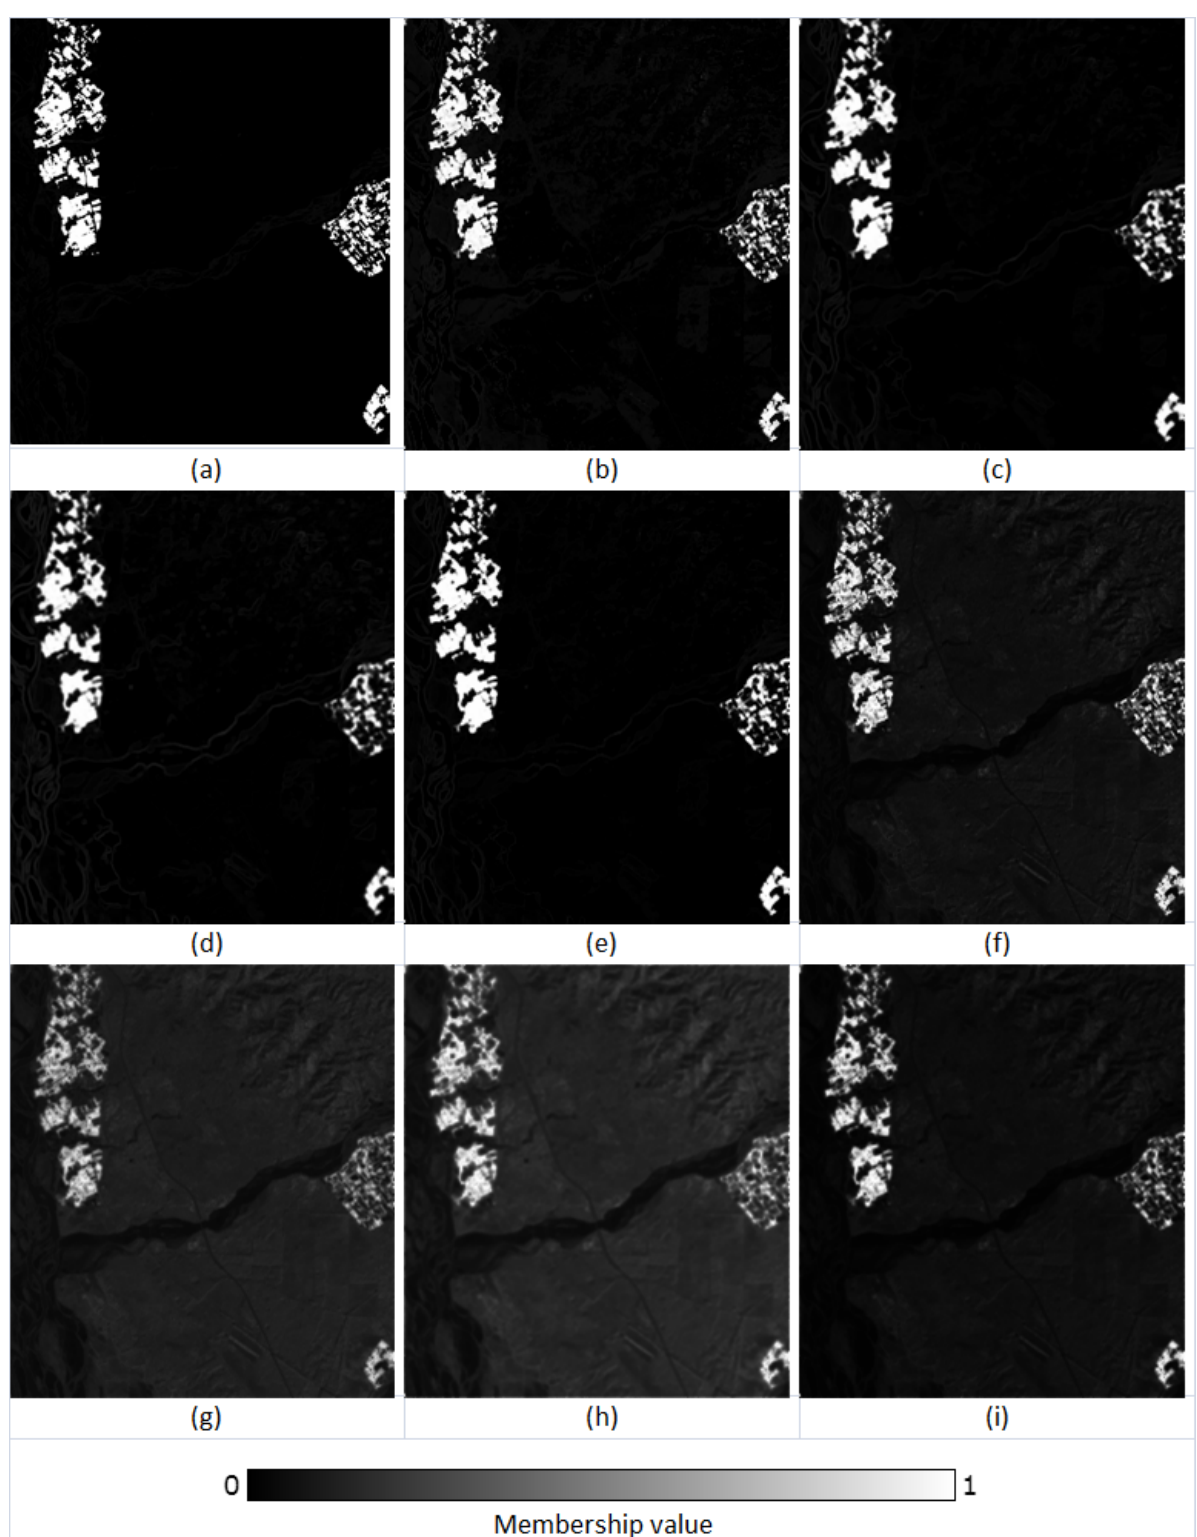
Figure 9. The membership fraction (0–1) for the class ‘Wheat’ in ( a ) reference, ( b ) FCM output, ( c ) FCM-S output, ( d ) FLICM output, ( e ) ADFLICM output, ( f ) PCM output, ( g ) PCM-S output, ( h ) PLICM output, and ( i ) ADPLICM output.